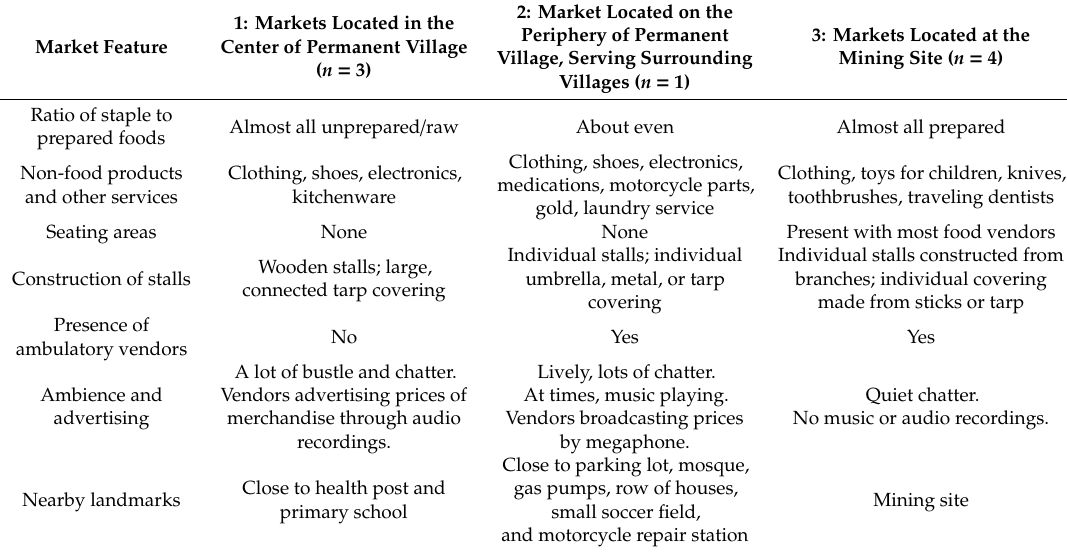
Table 5. Comparison table showing how markets are organized to respond to customer needs and improve accessibility of